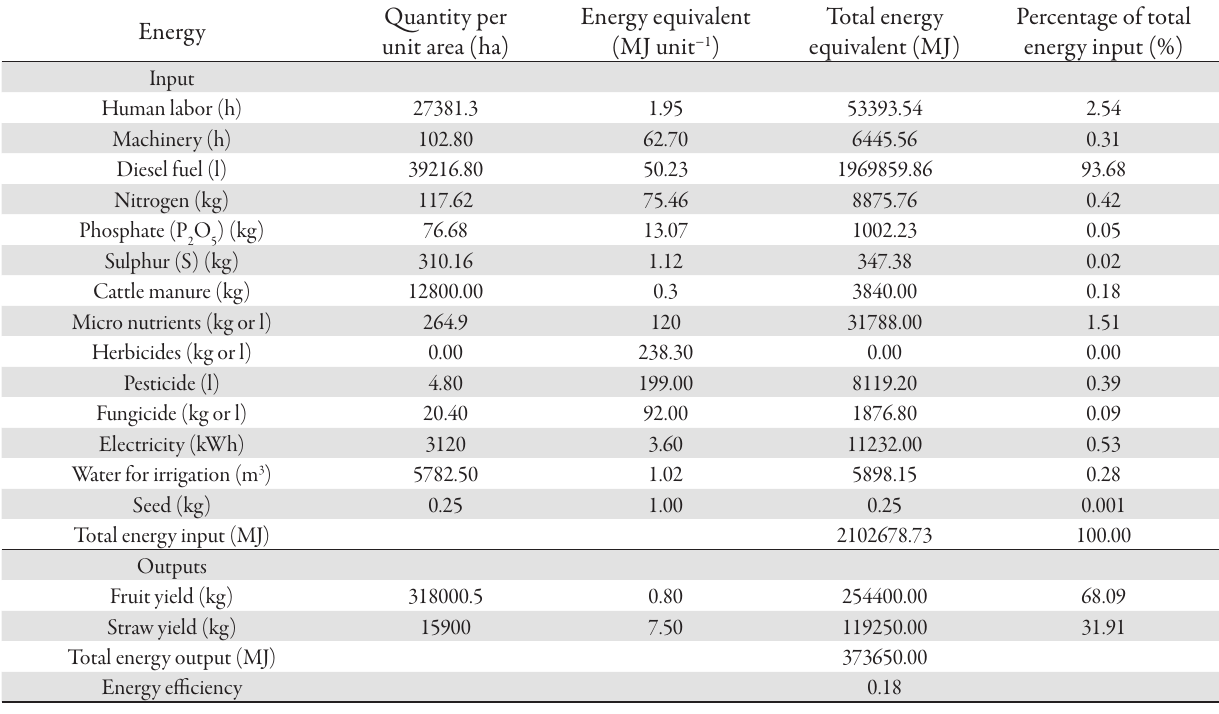
Tab. 4. Energy consumption and energy input-output relationship on greenhouse tomato production